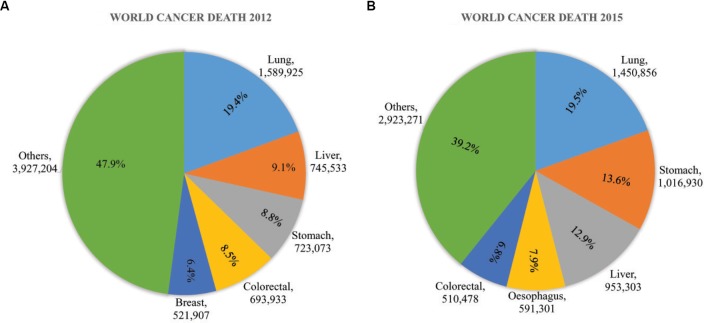
Global cancer impact in (A) 2012 and (B) 2015. In 2012, the death toll 8.2 million from 14 million new cases. It raised gradually to 8.8 million in 2015. The growth of cancer death was more than 7% from 2012 to 2015. The most common cancers were Lung cancer, liver cancer, stomach cancer, colorectal cancer, esophageal cancer, and breast cancer was a major threat of women cancer death worldwide. These figures were based on data published by WHO and GLOBOCAN (Ferlay et al., 2015; GBD 2015 Risk Factors Collaborators, 2016; WHO, 2018).